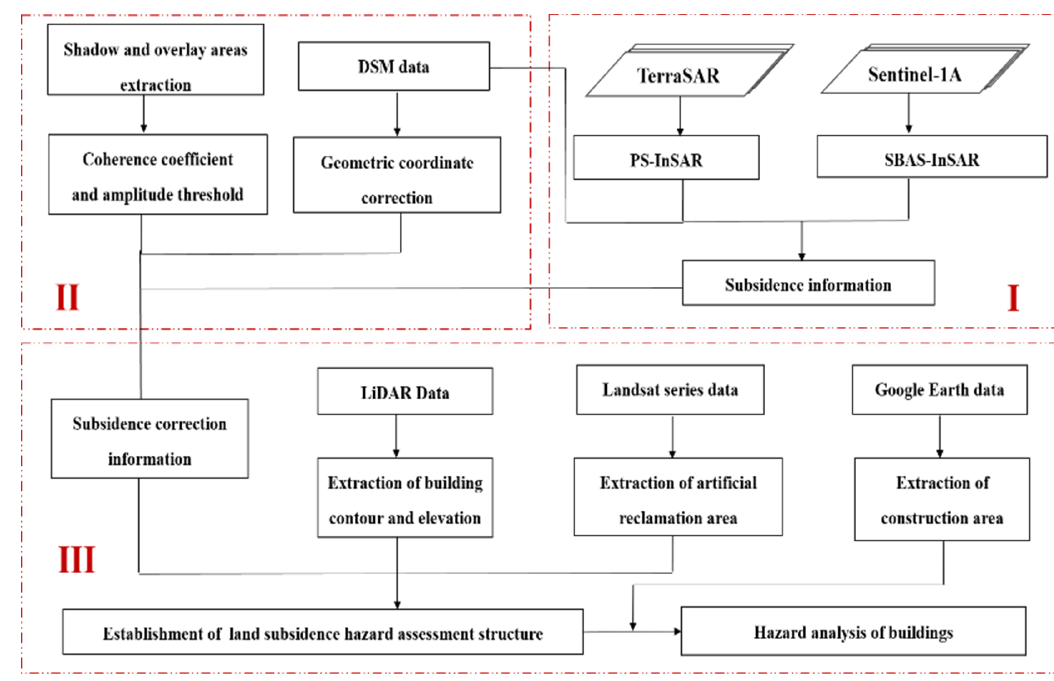
Figure 1. Workflow of the study.